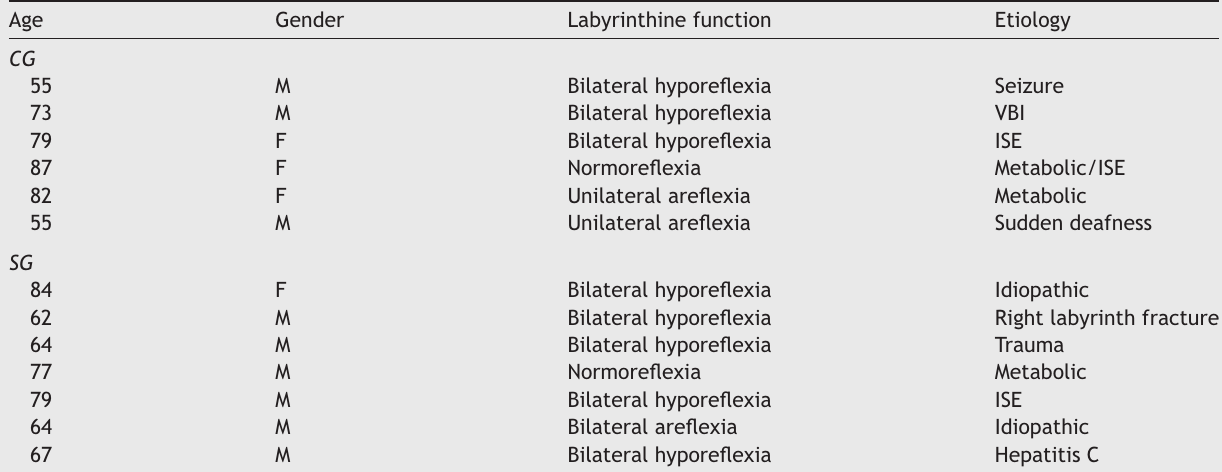
Presentation of CG and SG according to age, gender, vestibular function, and etiology of body imbalance. Age Gender